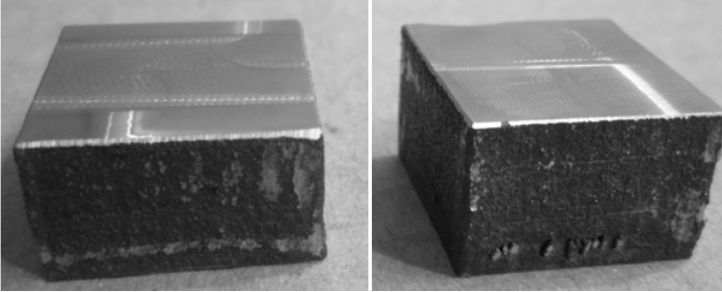
Figure 2. “Part on the left side is after machining with classical settings, part on the right shows the result with PSO optimization”. Source: authors.